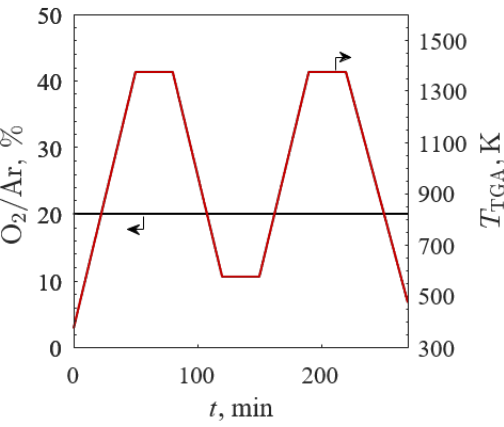
Figure 2. O 2 concentration in Ar (black line) and temperature (red line) profiles versus time between 573 and 1373 K in 20% O 2 / Ar for the first TGA screening.